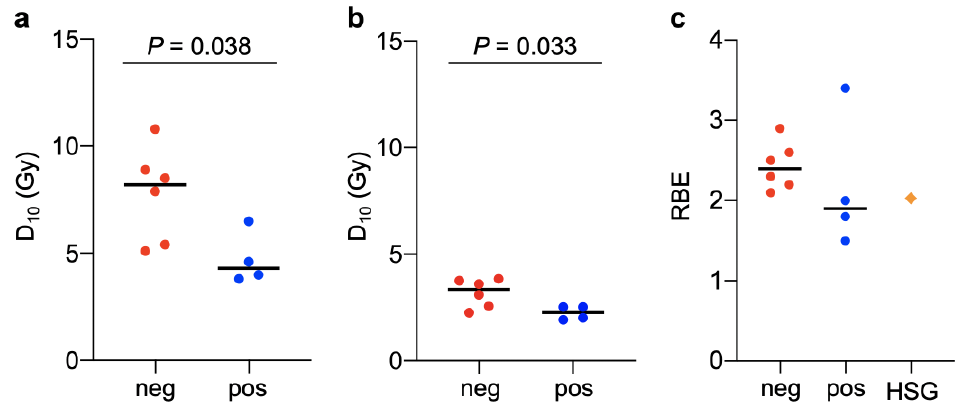
Figure 2. D 10 for X-rays ( a ), D 10 for carbon ions ( b ), and relative biological effectiveness (RBE) of carbon ions ( c ) for human papillomavirus-positive (pos) or -negative (neg) head-and-neck squamous cell carcinoma cell lines. RBE data for the HSGc-C5 cell line (HSG) were used as the reference. Black lines show median values. P -values as assessed by the Mann–Whitney U-test are shown.